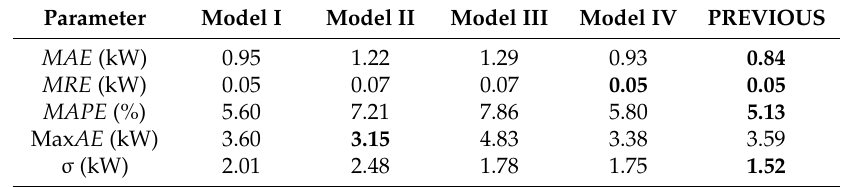
Table 13. Results obtained by MOGA and PREVIOUS models over Test B, for a PH of 1 h.